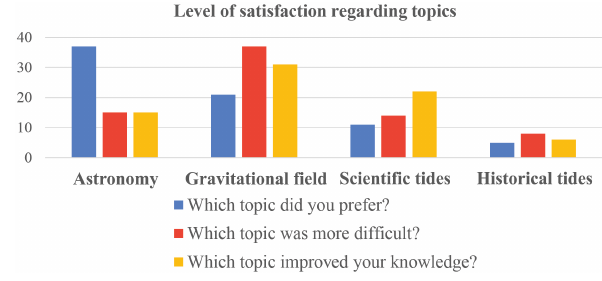
Figure 12. The histograms show the level of satisfaction regarding work-related learning internship topics.